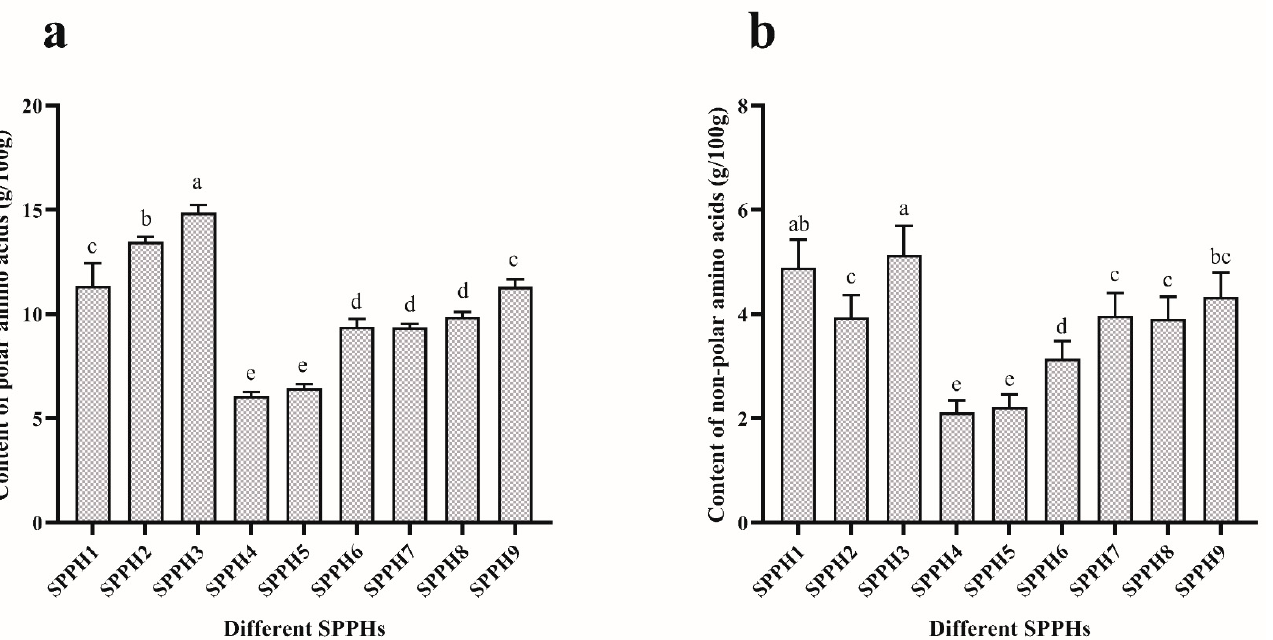
Figure 1. Amino acid content of SPPHs. ( a ) The content of polar amino acids in SPPHs. ( b ) The content of non-polar amino acids in SPPHs. All the data were analyzed by Duncan’s multiple comparisons; bars with no letter in common are significantly different at the level of p < 0.05.